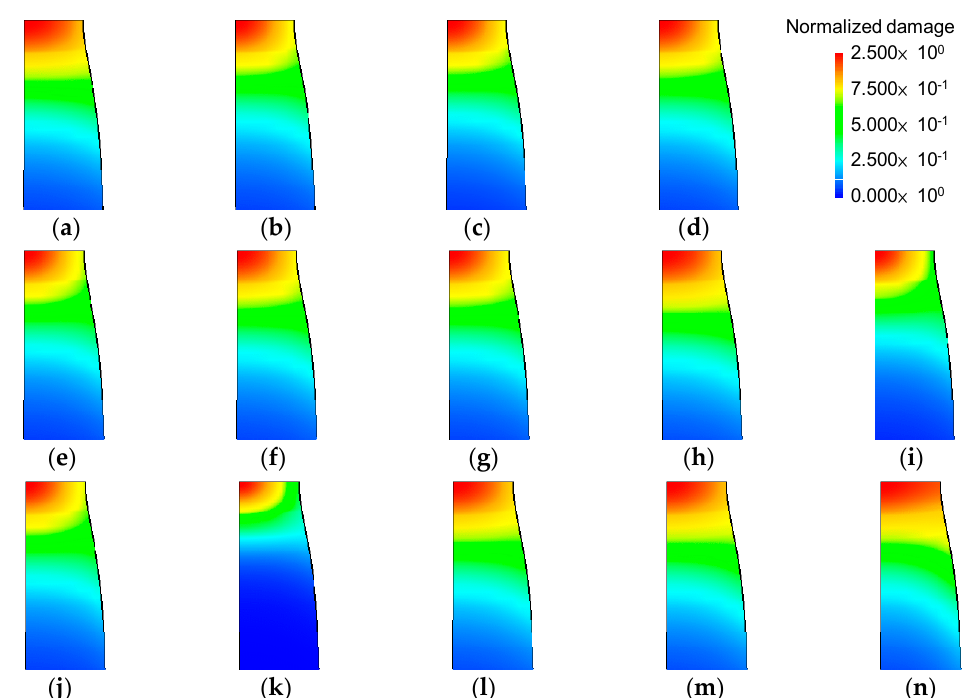
Figure 8. Prediction of normalized damage around the necking point at the fracture instant: ( a ) Freudenthal, ( b ) McClintock, ( c ) original Cockcroft-Latham (CL) ( d ) normalized Cockcroft-Latham(NCL), ( e ) Rice and Tracey (RT), ( f ) Brozzo et al. (BDR), ( g ) Norris et al. (NRMQ), ( h ) Oyane et al. (OSOS), ( i ) Chaoudadi et al. (CMV), ( j ) Rice et al. (Rice-Tracey-Cockcroft-Latham) (RTCL), ( k ) Ko et al. (KH), ( l ) Bai and Wierzbicki both unnormalized lode angles (BWUL), ( m ) Bai and Wierzbicki normalized lode angles (BWNL) and ( n ) Lou and Huh (LH).